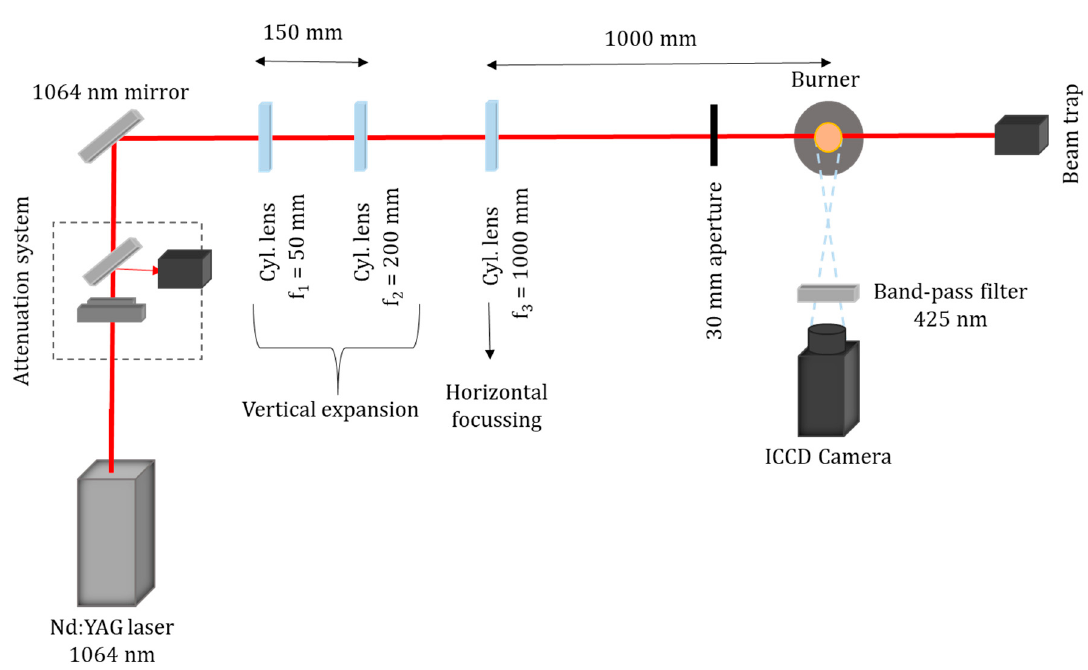
Figure 2. Schematic top-view of the optical set-up for 2D-LII measurements .